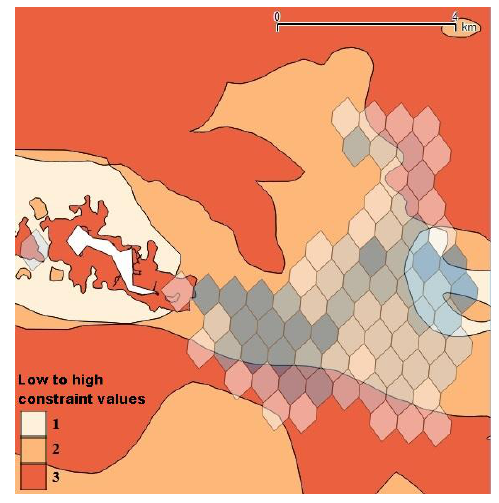
Figure 10. Ground line fishing